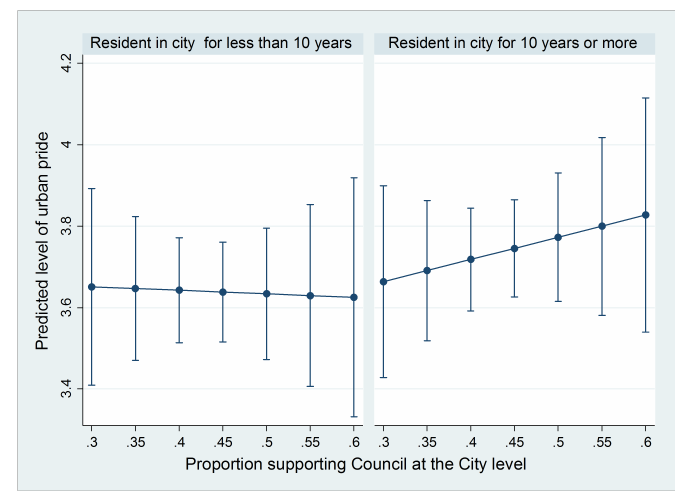
Source: Quality of Life Survey, 2008.